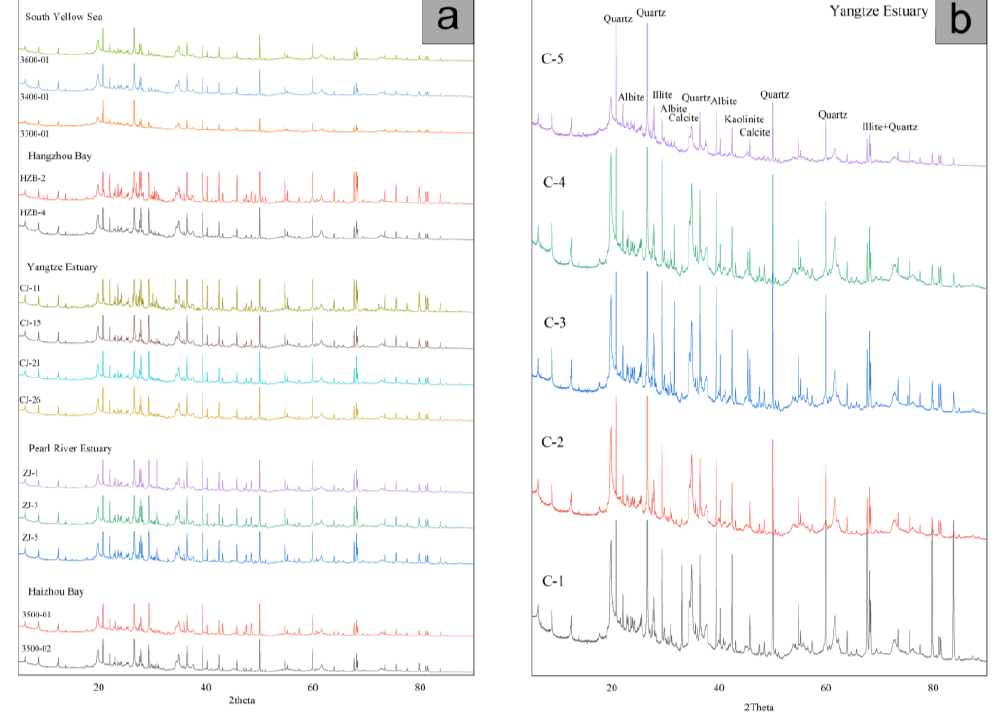
Figure 3. XRD pattern of suspended particulate matters ( a ). From offshore (Yellow Sea) to estuary (Yangtze Estuary); ( b ) from offshore (C-5) to estuary (C-1).